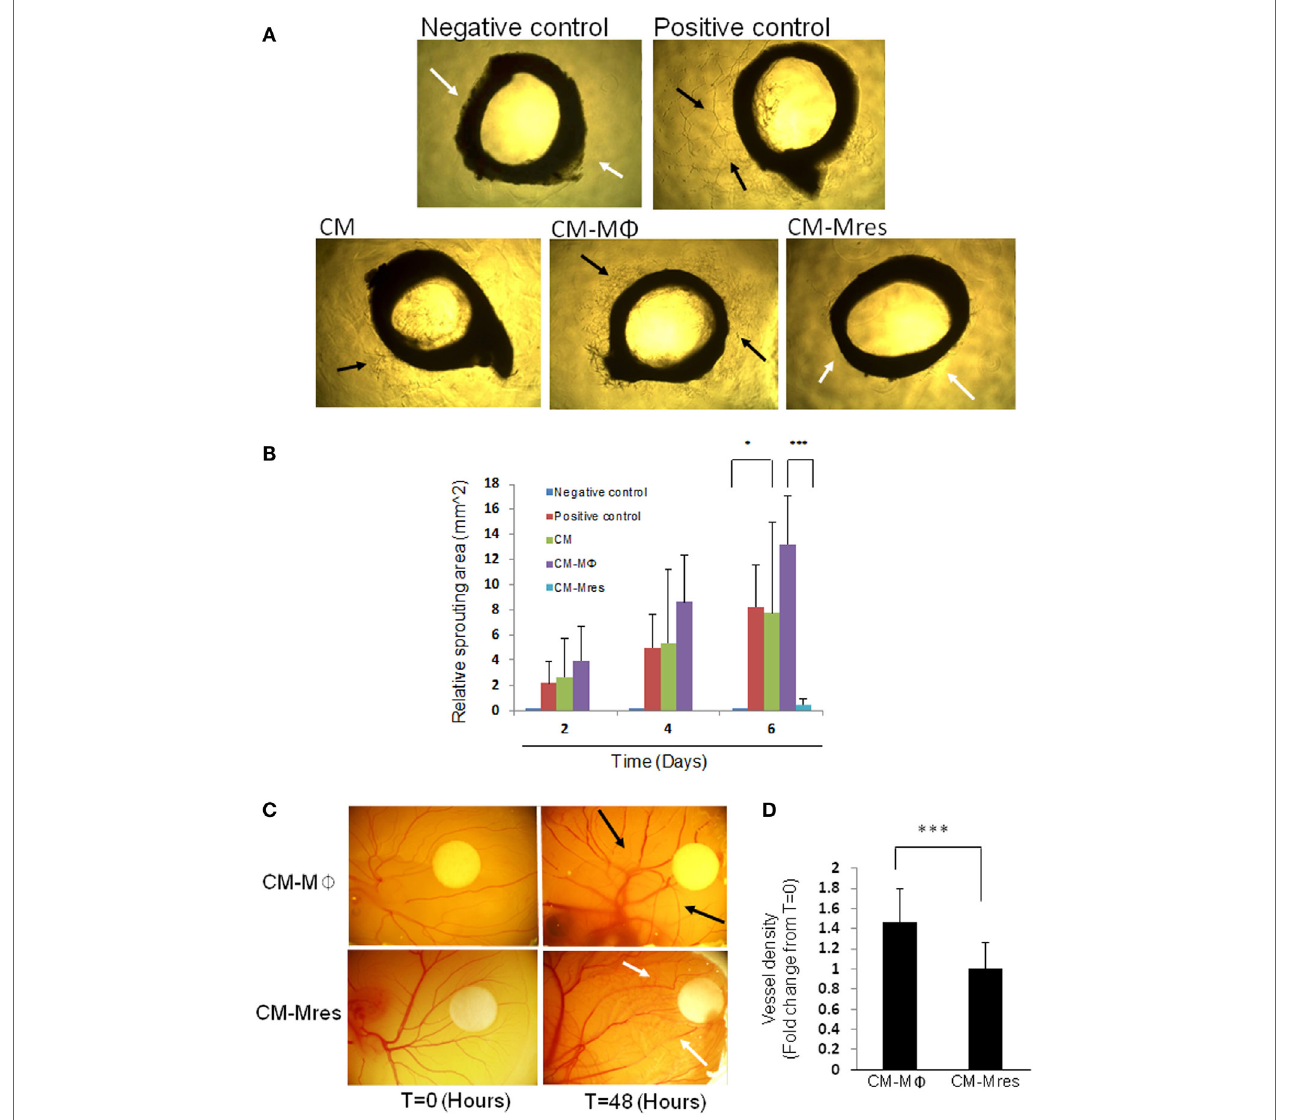
FigUre 4 | Effect of CM-Mres on angiogenesis of rat aorta ring and chick chorioallantoic membrane (CAM). (a) Rat aortic ring assay. Representative photomicrographs of rat aortic ring sections from 6-week-old rat cultured on basement membrane extract and treated for 6 days with basal media (negative control), basal media with supplementations (positive control, see Materials and Methods), condition medium (CM), CM-M ϕ , or CM-Mres. Vascularized area is indicated by black arrow heads, and avascular area is indicated by white arrow heads. (B) Quantification of the sprouting area of endothelial cells relative to T = 0. Columns; mean, bars; STD, n = 2 with three replicates for each treatment, two-way repeated measures ANOVA analysis with repeated contrasts * p ≤ 0.05, *** p ≤ 0.001. (c) Representative images of the chick CAM treated for 48 h with either CM-M ϕ ( n = 15) or CM-Mres ( n = 12). Vascularized area is indicated by black arrow heads, and avascular area is indicated by white arrow head. (D) Quantification of vessel density in panel (c) . Columns; mean of the fold change in vessel density from t = 0 for each treatment, bars; STD, t -test, *** p ≤